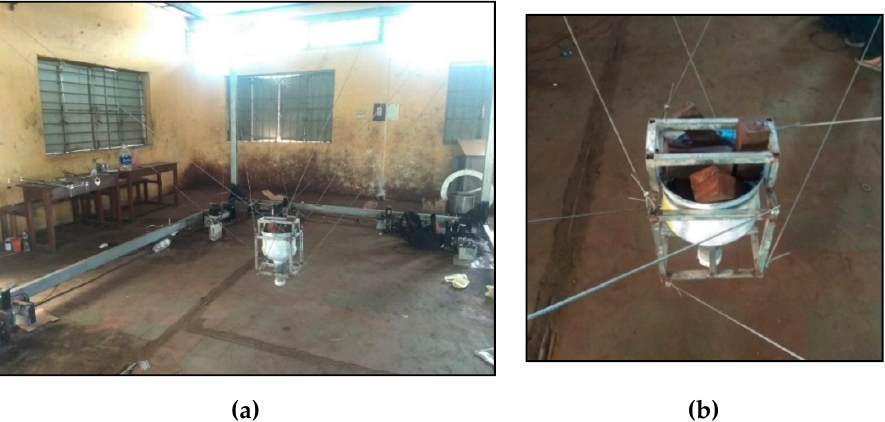
Figure 23. Our prebuilt spatial CDPM with 2 redundant actuators used in experiment ( a ) perspective view; ( b ) end-effector.